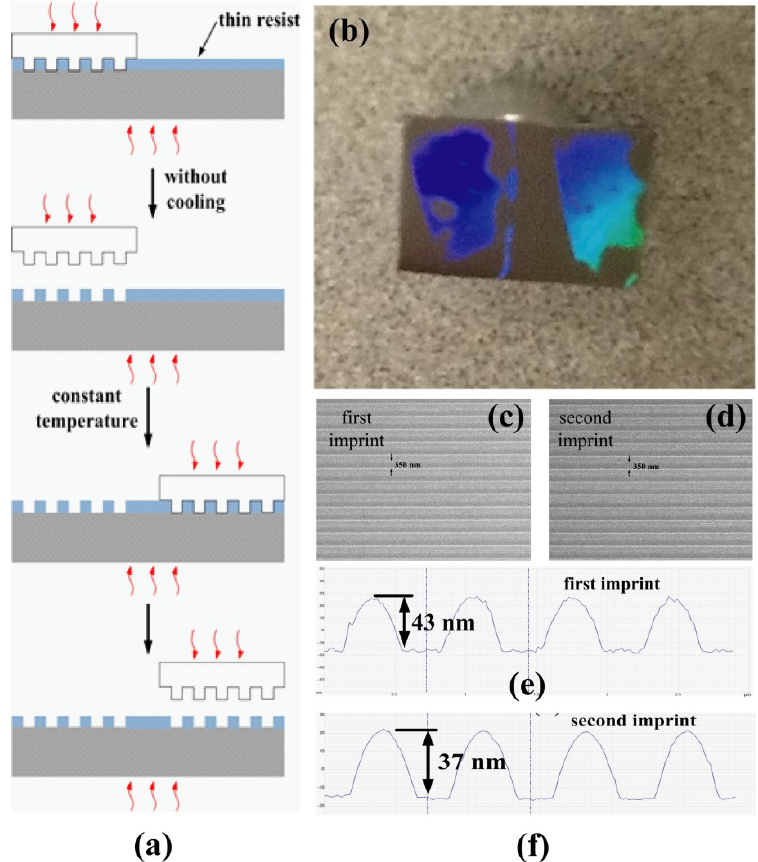
Figure 5. ( a ) The schematics of step-and-repeat thermal nanoimprinting and ( b ) a photograph of two imprinted regions within the same substrate by a step-and-repeat thermal nanoimprinting. ( c , d ) are SEM images of polycarbonate gratings patterned by the first imprint and the second imprint, respectively. ( e , f ) are the heights of the gratings of the first and the second imprint scanned by AFM, respectively.